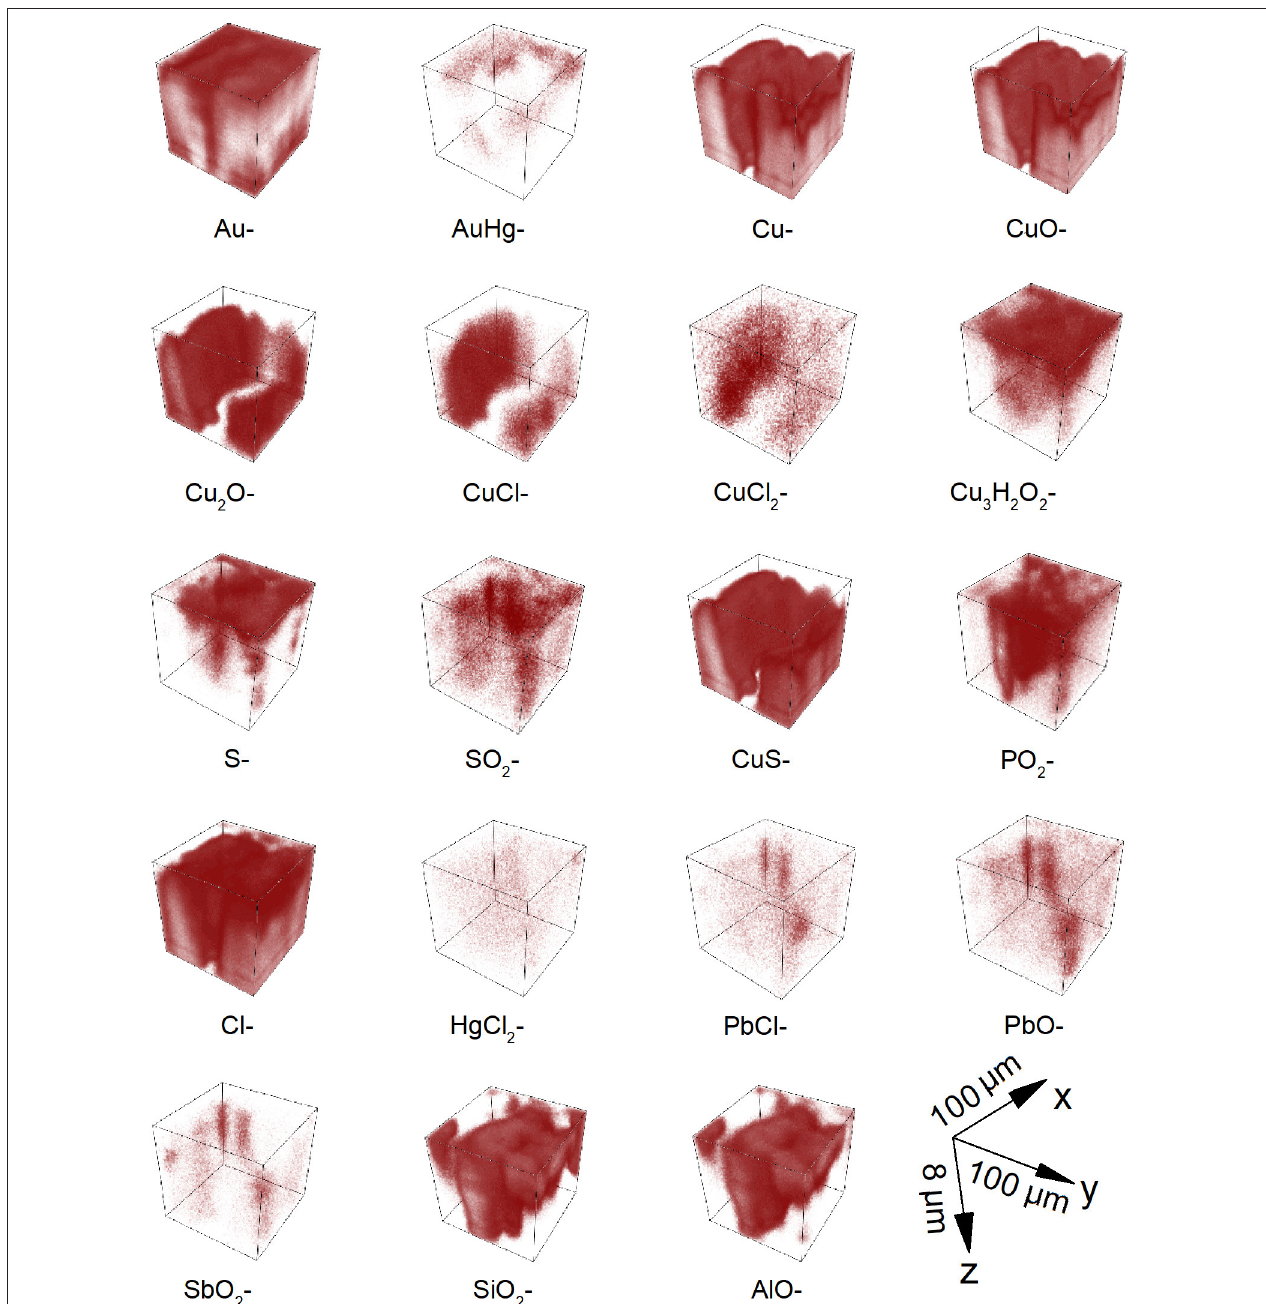
FIGURE 5 | ToF-SIMS 3D imaging of corroded area from gilded copper-based object showing the spatial distribution of selected ions. The reported ion signals were selected as representative of corrosion process and/or material coming from the burial soil. The sputtered away volume represented in the 3D renders was estimated to be 100 × 100 × 8 µ m 3 by using